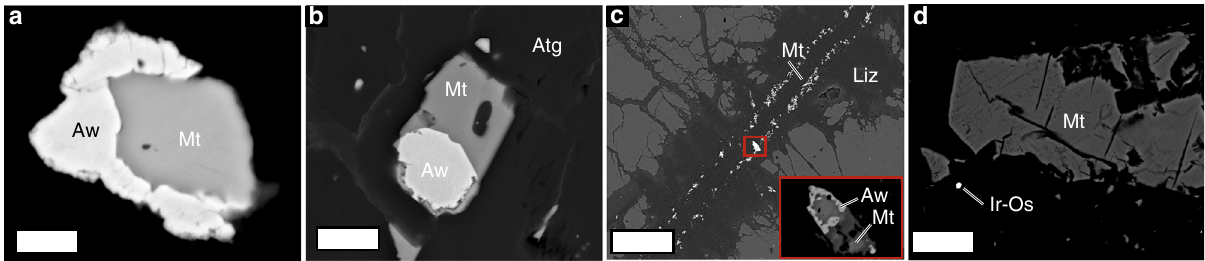
Fig. 2 Redox buffers in the antigorite serpentinized ultrama fi c pseudotachylytes. a , b Awaruite and magnetite relationships in the antigorite serpentinized pseudotachylyte-bearing peridotites. c Magnetite and awaruite in late lizardite (Liz) veins showing the protracted reducing conditions during late-stage alteration. d Ir – Os particle in association with antigorite and magnetite (Supplementary Fig. 10 for details). Scale bars: a , b 2 µ m; c 50 µ m; d 6 µ m. Other mineral abbreviations as in Fig. 1.